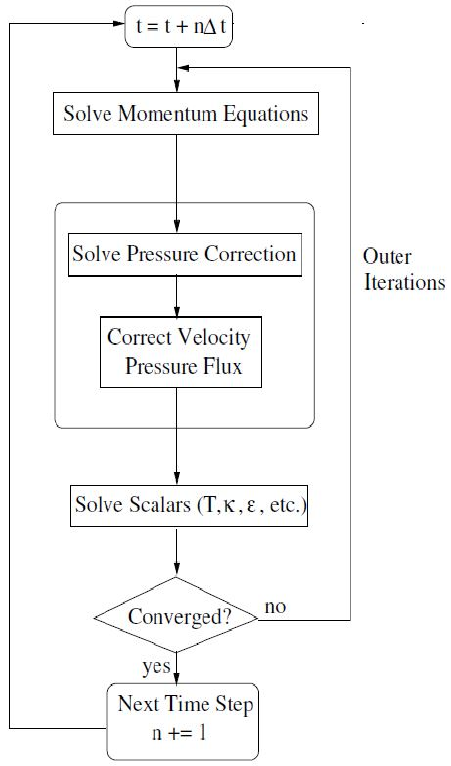
Figure 12. Iterative time advancement method chart.